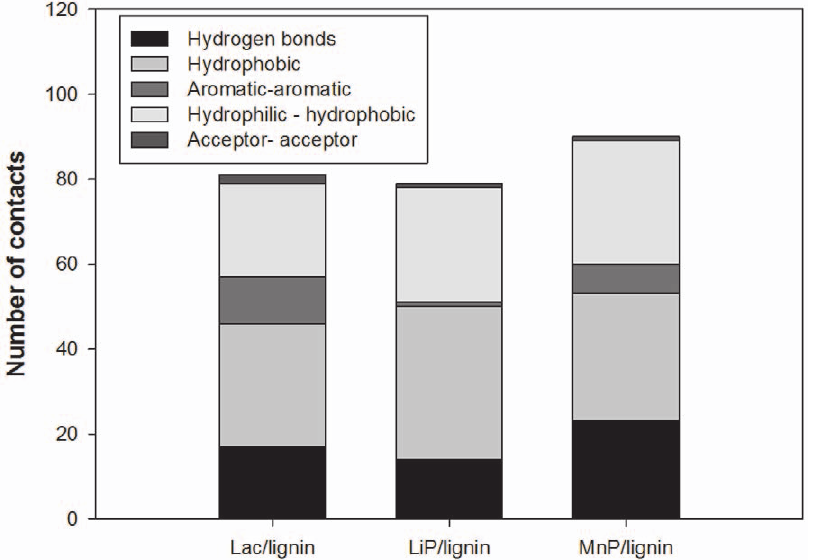
Figure 3. Number of lignin-enzyme contacts in the best docking Lac-lignin, LiP-lignin and MnP-lignin complexes. Analyzed ligand– protein contacts include hydrogen bonding (Hb), hydrophobic (Ph) contact, aromatic-aromatic (Ar) contact, hydrophilic-hydrophobic (HH) contact, and acceptor-acceptor (AA) contact. doi:10.1371/journal.pone.0025647.g003 PLoS ONE |